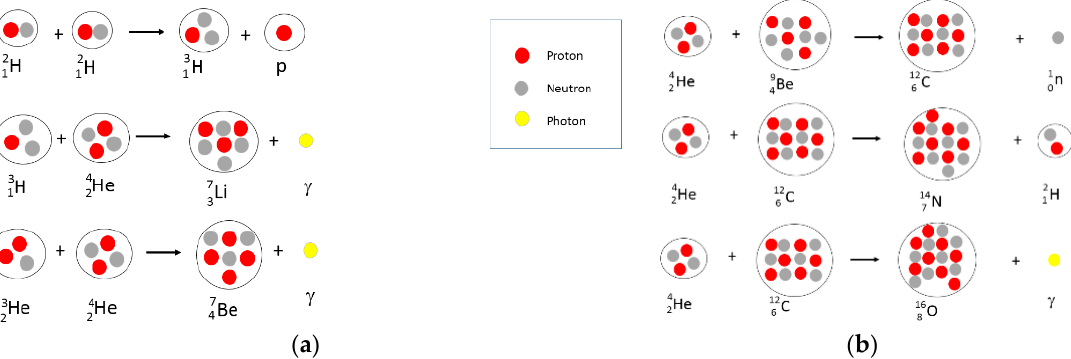
Figure 3. Hypothetic nucleosynthesis scheme for Li and Be production ( a ) and C, N, O possible nucleosynthesis ( b ).